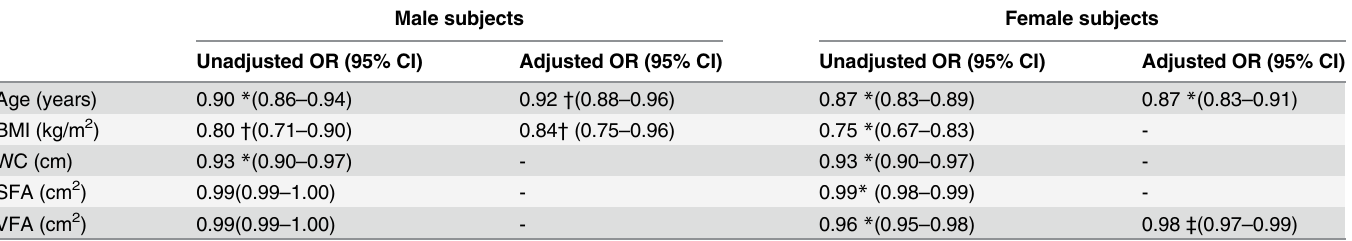
Table 3. The unadjusted and adjusted ORs and 95% CI from the logistic regressions predicting the likelihood of positive BAT in the subgroup with low outdoor temperature ( < 20°C).